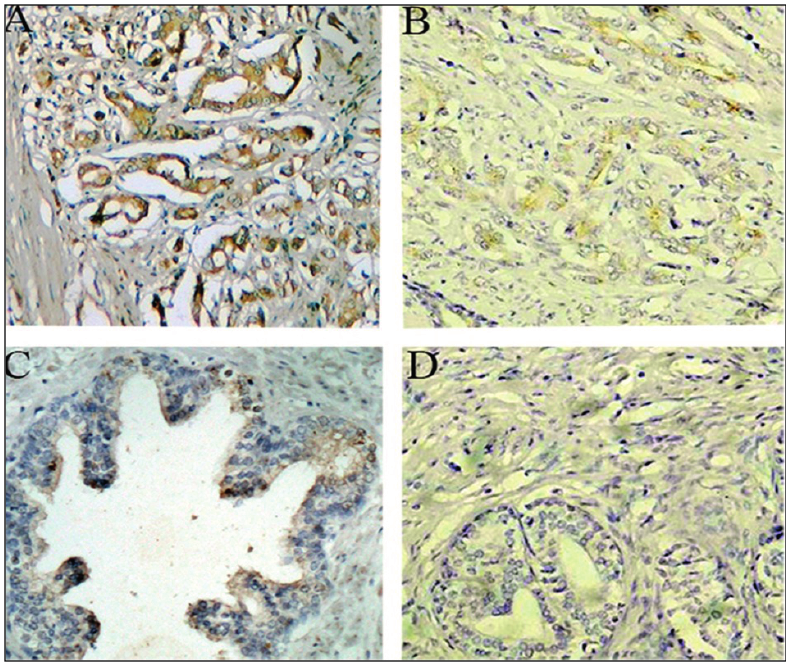
Figure 2. Immunohistochemical staining for PTK7 in prostate cancer and benign prostate tissue (original magnification ×200). ( A ) High PTK7 protein expression was found in cytoplasm of prostate cancer tissues; ( B ) Low PTK7 protein expression was found in cytoplasm of prostate cancer tissues; ( C ) PTK7 weakly positive staining was found in cytoplasm of benign prostate tissue; and ( D ) Negative immunostaining of negative controls with the primary antibody omitted in prostate cancer